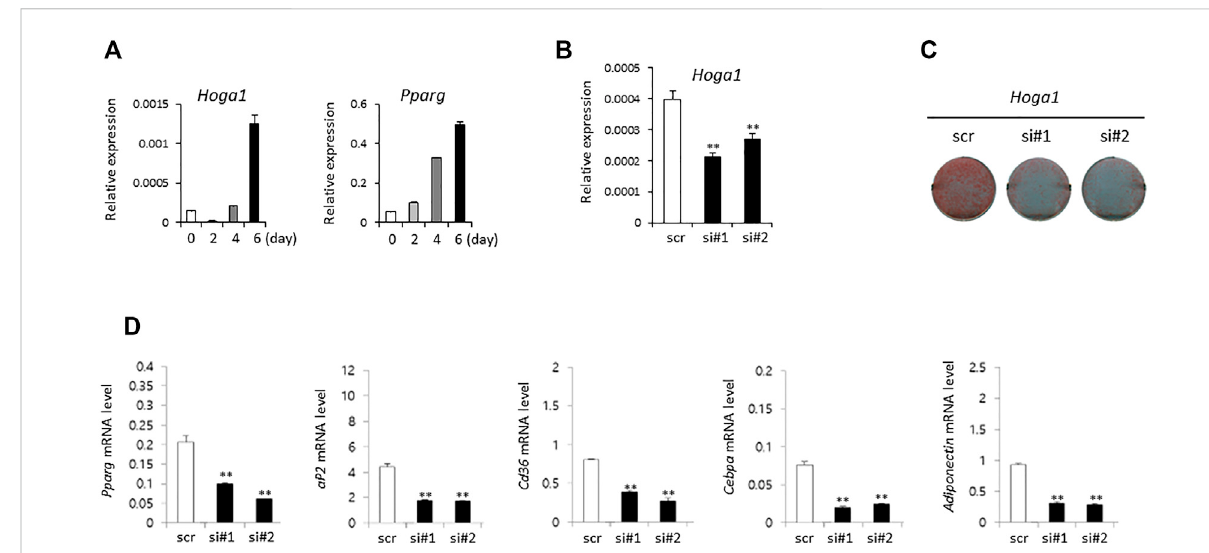
FIGURE 3 The effect of Hoga1 knockdown on adipogenesis in mouse 3T3-L1 cells. (A) Relative expression levels of Hoga1 and Pparg during adipocyte differentiation. (B) Hoga1 knockdown ef fi ciency of two independent siRNAs (si#1 and si#2) compared to scrambled control siRNA (scr). (C) Lipid accumulationduringadipocytedifferentiationin3T3-L1pre-adipocytestransfectedwithtwoindependent Hoga1 -targetingsiRNAsorscrsiRNA.Red dots indicate lipid droplets stained with Oil-Red-O. (D) Expression levels of Pparg , aP2 , Cd36 , Cebpa , and Adiponectin genes related to adipogenesisin3T3-L1pre-adipocytestransfectedwithtwoindependent Hoga1 -targetingsiRNAsorscrsiRNA.Notes:ThemRNAlevelofeachgene was measured on day 1 after treatment with each Hoga1 -siRNA or scr siRNA by RT-qPCR analysis. Results are expressed as the mean ± SD of three independent experiments (* p < 0.05 and ** p < 0.01 vs scrambled